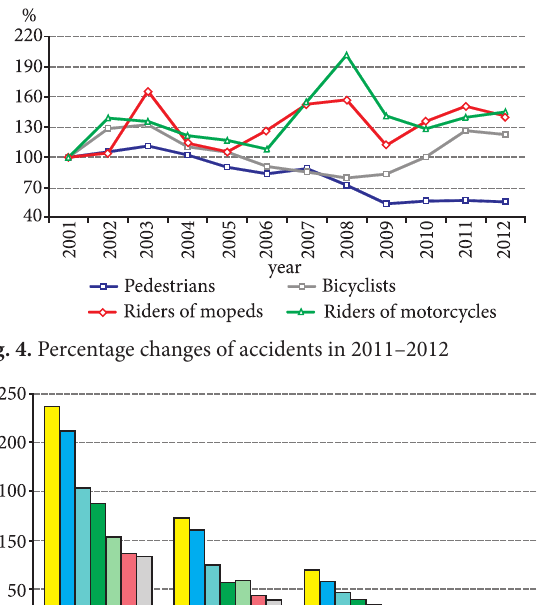
Fig. 3. Number of killed per 1 million inhabitants in the EU member states in 2001 and 2012 (Source: Back on Track to Reach the EU 2020 Road Safety Target? 7 th Road Safety PIN Report, 2013)